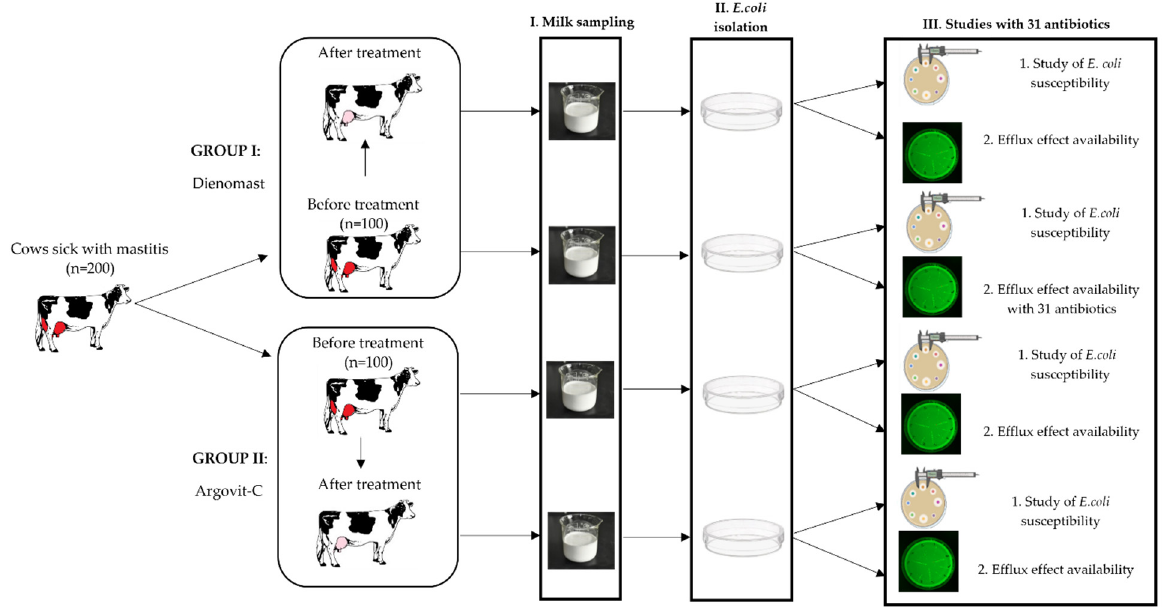
Figure 1. Diagram of experimental design for E. coli isolates before and after treatments with Dienomast TM and Argovit-C TM : stage I—milk sampling, stage II—isolation of E. coli , and stage III—studies of the sensitivity of E. coli to 31 antibiotics and the presence of efflux effect.